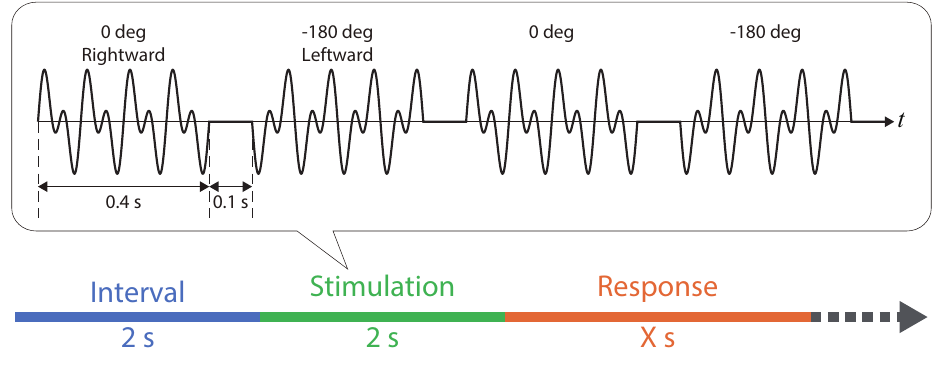
Figure 5. Stimulation and